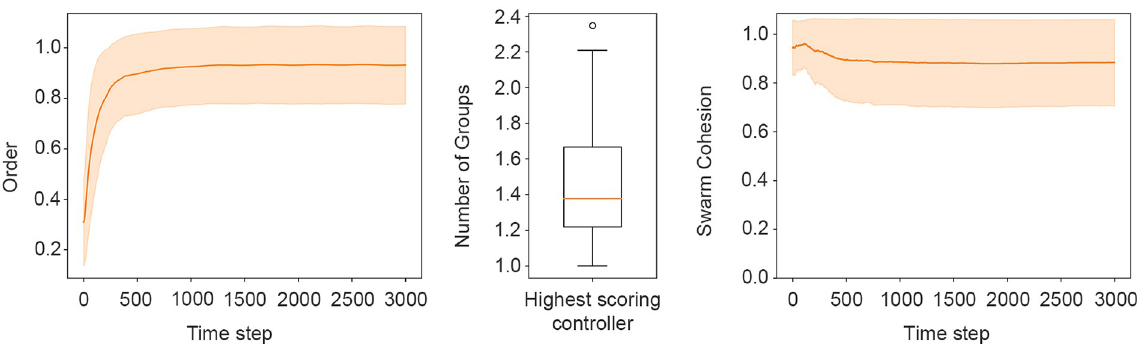
Fig 2. The figure summarises results of the average from the 400 post-evaluation samples of the highest-scoring controller in terms of the metrics presented in Section Metrics. Left: The order metric trajectory across the 3000 simulation steps. Centre: box-plot of the distribution of the number of groups metric. Right: The swarm cohesion trajectory across the 3000 simulation steps. The shaded areas indicate the standard deviation.